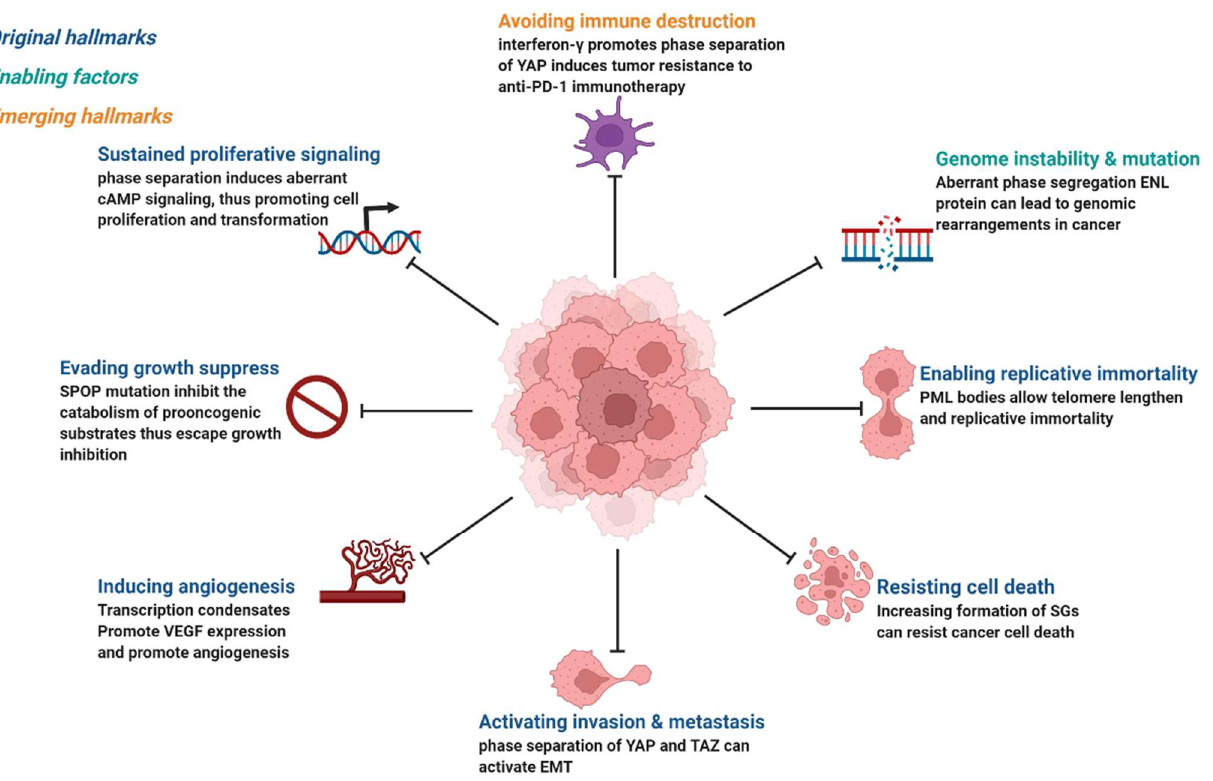
Figure 3. Phase separation abnormalities are involved in most of the processes known as cancer hallmarks. Created with BioRender.com.